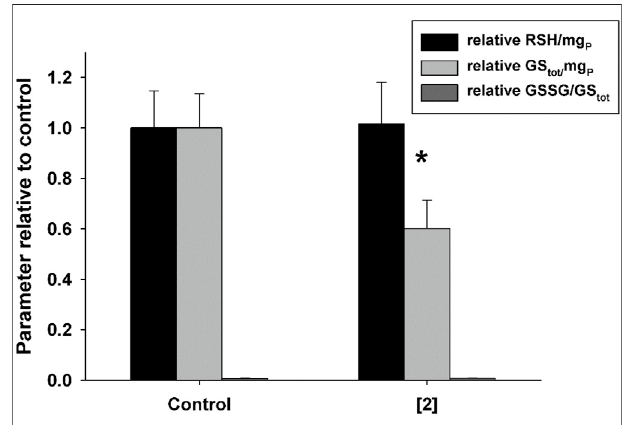
FIGURE5| Effectofcompound 2 onthetotalcontentofthiols(RSH)and glutathione (GStot) and on the GSSG/GS tot ratio in A2780. Cells were treated with 0.2 μ M compound 2 for 48 h. Mean values and SD from three independent experiments are shown. * p < 0.05 signi fi cant difference in comparison to the control sample.